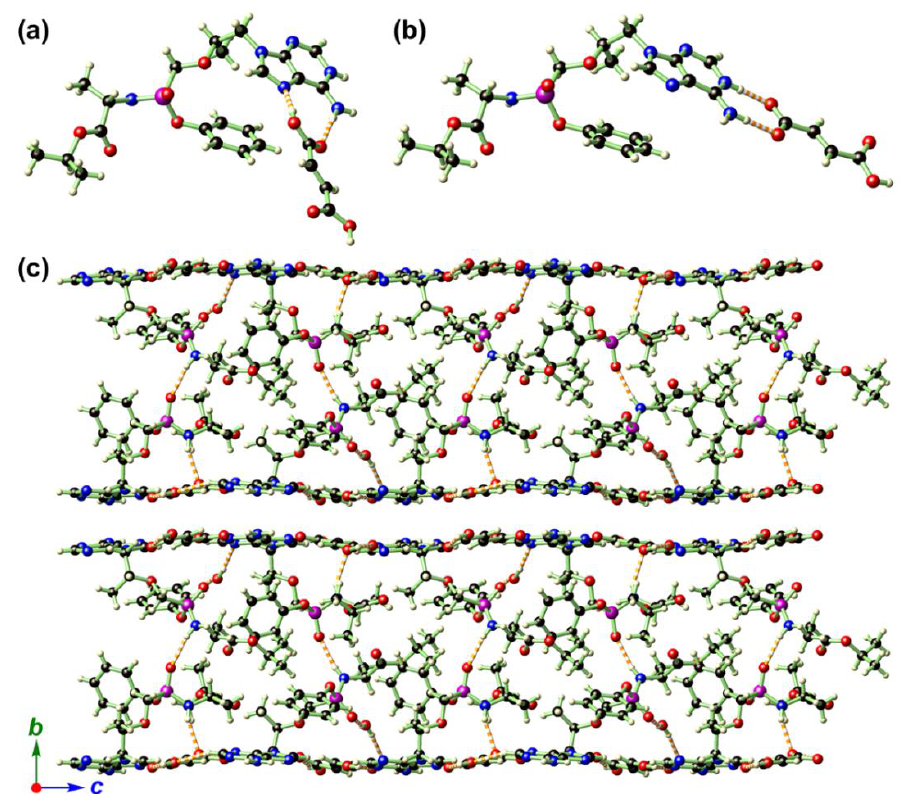
Figure 4. The structure of 2 showing ( a , b ) two independent TAF fumarate pairs in the asymmetric unit. In ( b ), the proton on the fumarate was found to migrate to the adenine moiety, and, as a result, the hydrogen-bonding modes in the two TAF fumarate pairs were drastically different. ( c ) depicts the crystal packing diagram of 2 when looking along the crystallographic a direction, showing its extensive hydrogen-bonding interactions and sandwich-type structure. Color codes: P (magenta), O (red), N (blue), C (black), H (light-yellow).